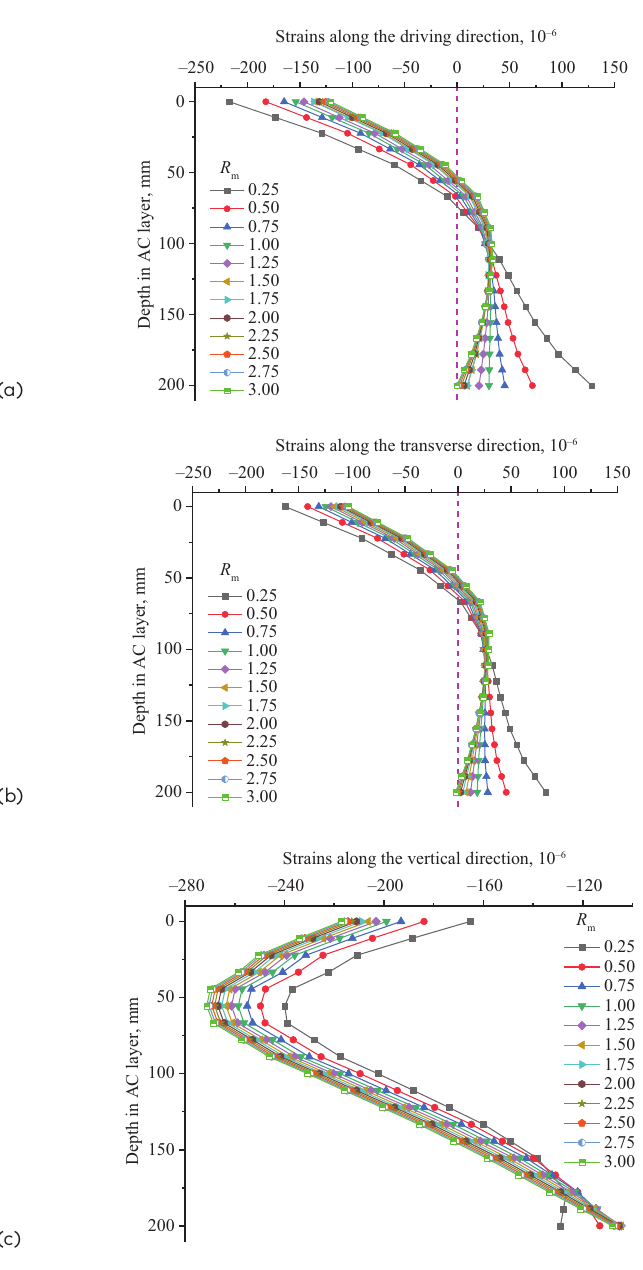
Figure 4. Distribution of critical strains along the depth in the AC layer: (a) strains along the driving direction, (b) strains along the transverse direction, (c) strains along the vertical